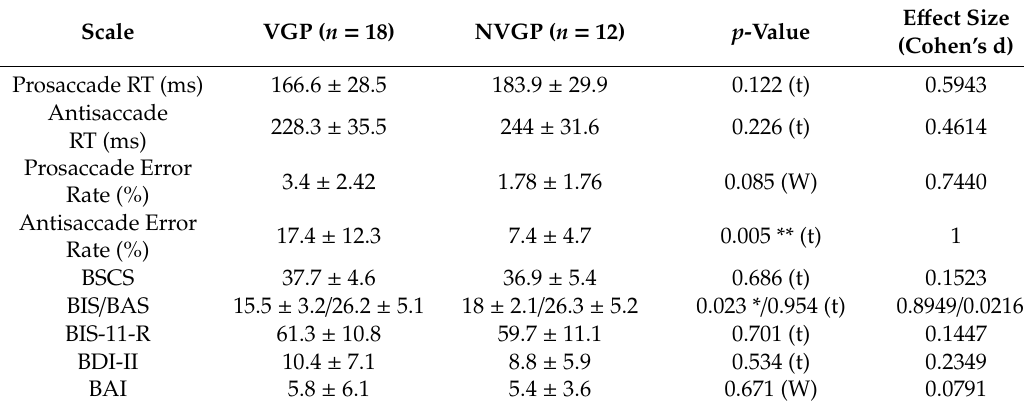
Table 1. Verification of statistical di ff erences between VGP and NVGP.